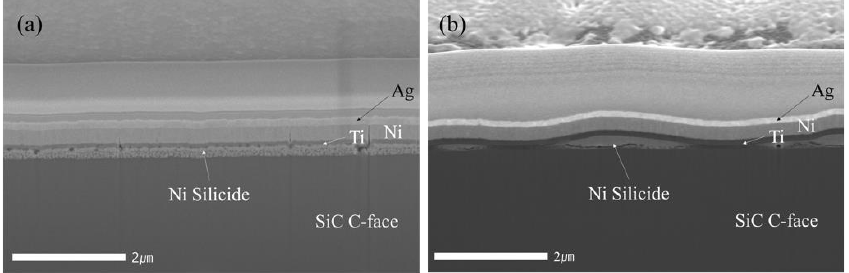
Figure 3. ( a ) RTA silicide ohmic contact and ( b ) laser silicide ohmic contact cross-sectional SEM images for the SiC C-face of Ni thicknesses of 100 nm in the fabricated JBS diodes.